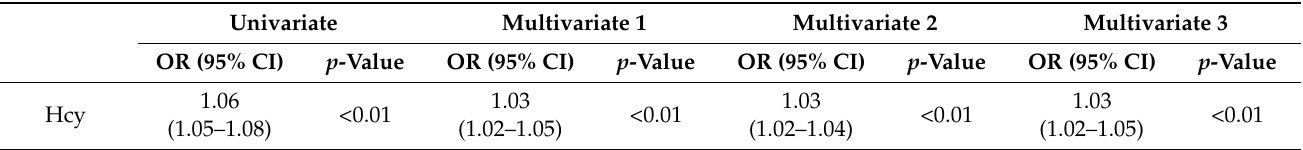
Table 2. The association between metabolic syndrome and homocysteine in the KARE cohort.